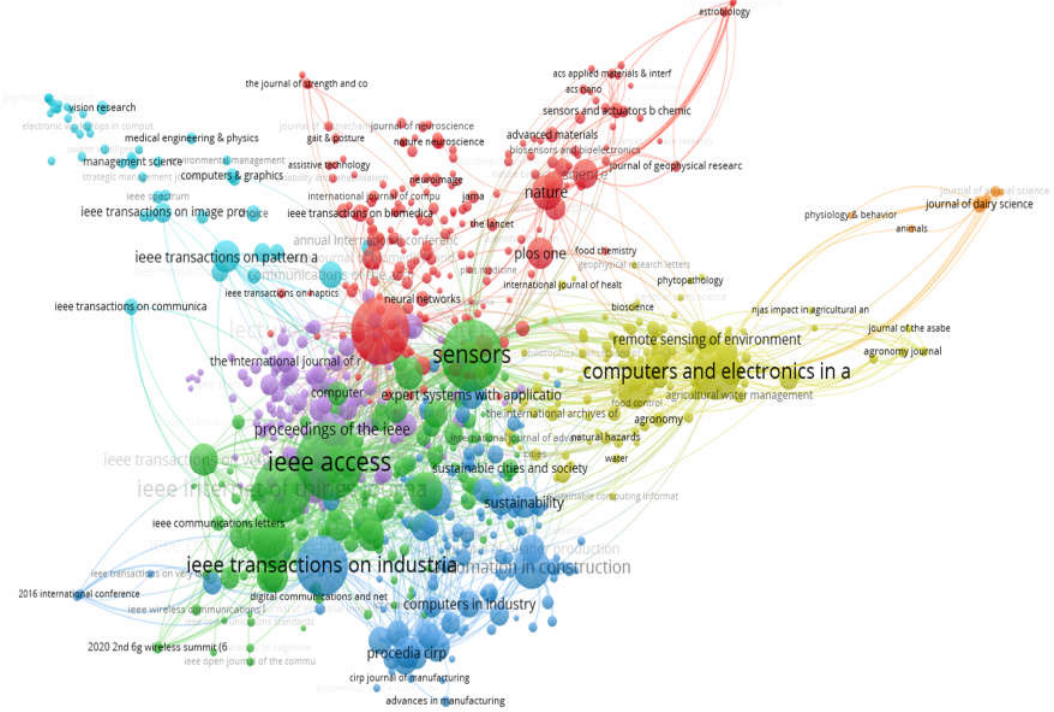
Figure 4. VOSviewer mapping of remote big data management tools, sensing and computing technologies, and visual perception and environment mapping algorithms in the Internet of Robotic Things regarding co-citation.